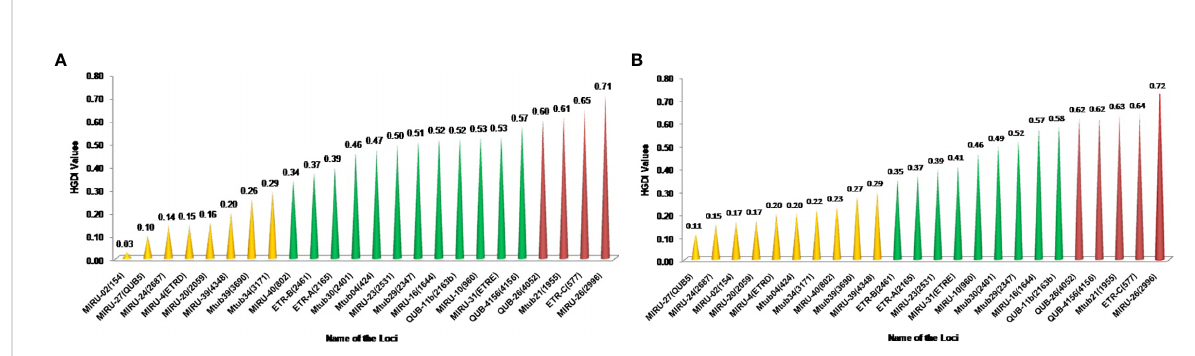
FIGURE 2 (A) Minimum spanning trees of MTC isolates from HIV-negative patients typed with both spoligotyping and MIRU-VNTR. Each circle represents a genotype. The distance between circles represents how closely related the different genotypes are to each other. MST connects each genotype based on the degree of changes required to go from one allele to another. The con fi guration of the tree is represented by branches i.e . continuous versus dotted lines and circles representing each pattern. The length of the branches denotes the distance between patterns whereas the intricacy of the lines indicates the number of spacers altered between two patterns. The thicker lines represent one change while thinner ones indicate 2 or 3. The size of the circle is comparable to the total number of MTB isolates in this study. The color of the circles represents the phylogenetic lineage to which the speci fi c pattern belongs. Beijing patterns are circled in red. Patterns colored in green indicate Delhi/CAS strains. EAI strains are depicted in yellow. (B) Minimum spanning trees of MTC isolates from HIV-positive patients typed with both spoligotyping and MIRU-VNTR. Each circle represents a genotype. The distance between circles represents how closely related the different genotypes are to each other (detailed description as mentioned in Figure 3A).